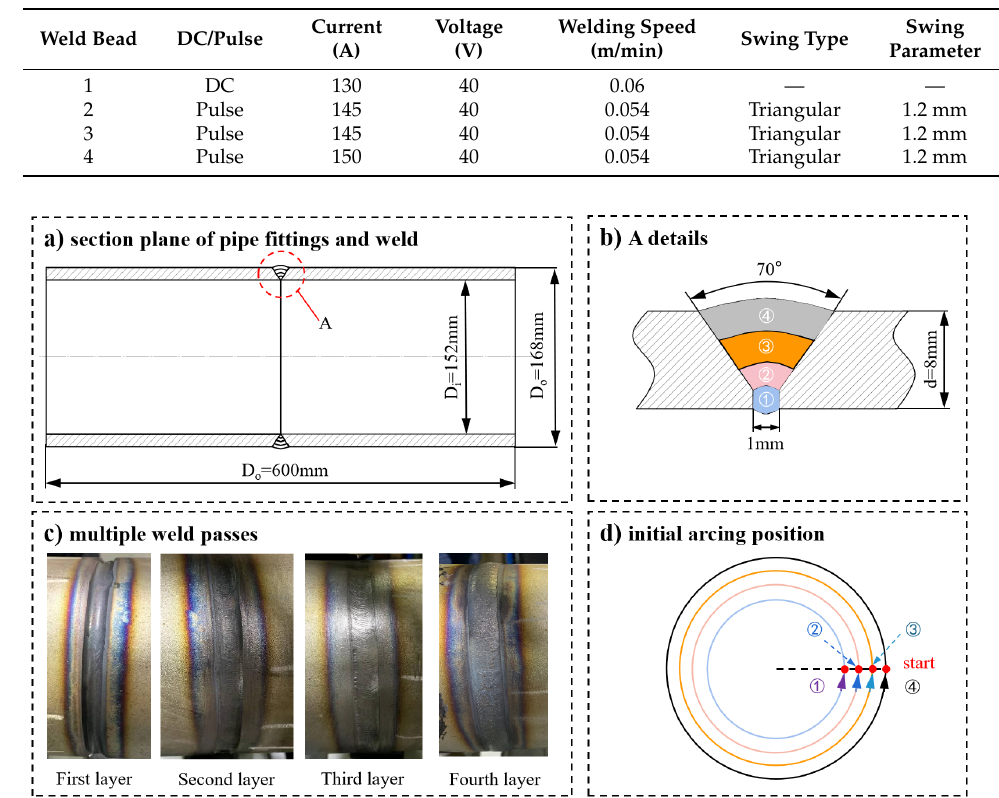
Figure 4. Weld bead interlayer process parameters.